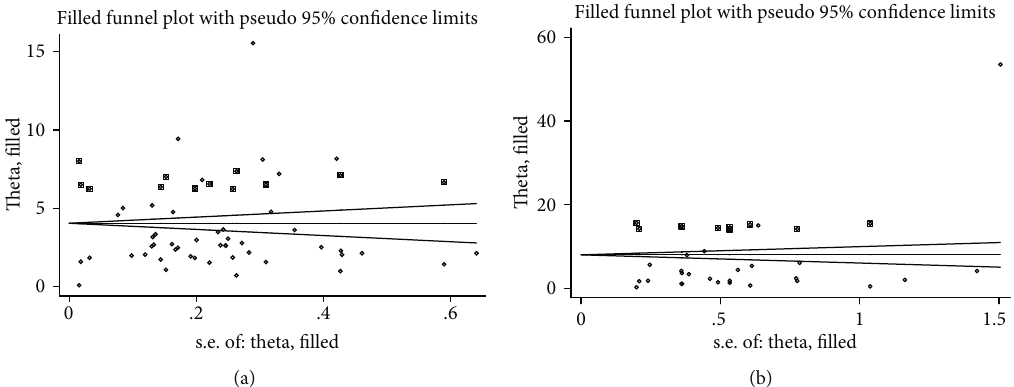
Figure 4: Egger ’ s funnel plot of the publication bias improved by the trim and fi ll method for factors of GDM: (a) prepregnancy overweight or obese and (b) history of